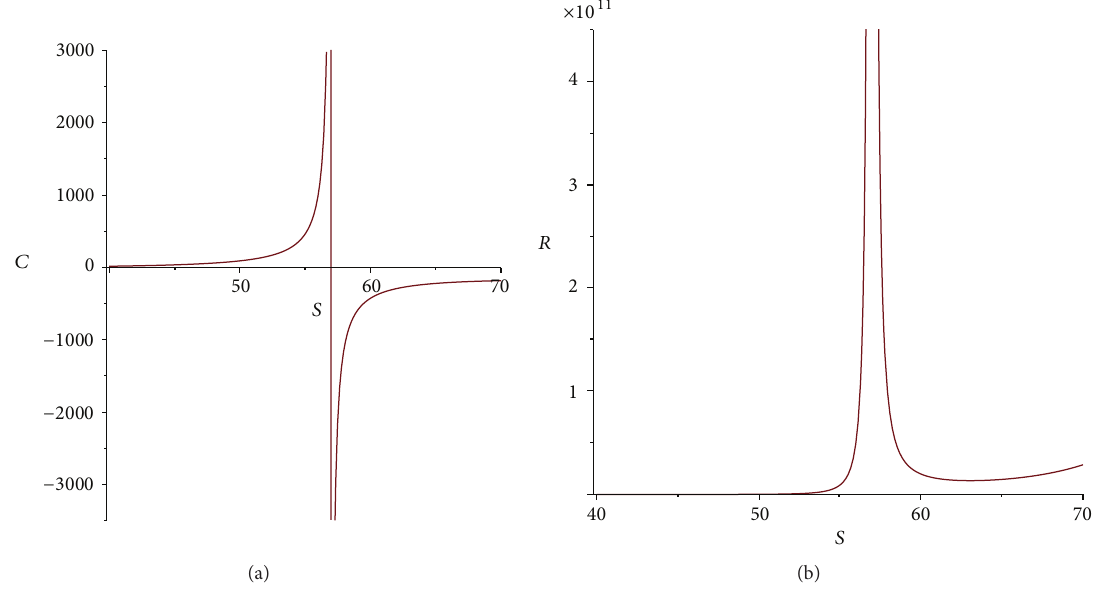
Figure 2: (a) Characteristic behaviour of the heat capacity as a function of the entropy 𝑆 . The divergence indicates the point of a phase transition. (b) Behaviour of the thermodynamic curvature scalar 𝑅 as a function of the entropy 𝑆 . The singularity is located at the point of the phase transition. In both figures, the noncommutativity parameter is set to 𝜃 = 0.5